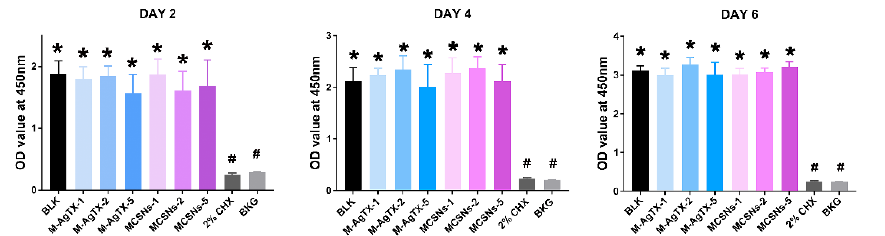
Figure 5. CCK-8 results among groups. (BLK: blank control group; BKG: medium background; M-AgTX-1, M-AgTX-2, M-AgTX-5: 1, 2, 5 mg/mL M-AgTX groups; MCSNs-1, MCSNs-2, MCSNs-5: 1, 2, 5 mg/mL MCSNs groups; *, #: significant difference when compared with 2% CHX group, and BLK group, respectively, p < 0.05.).